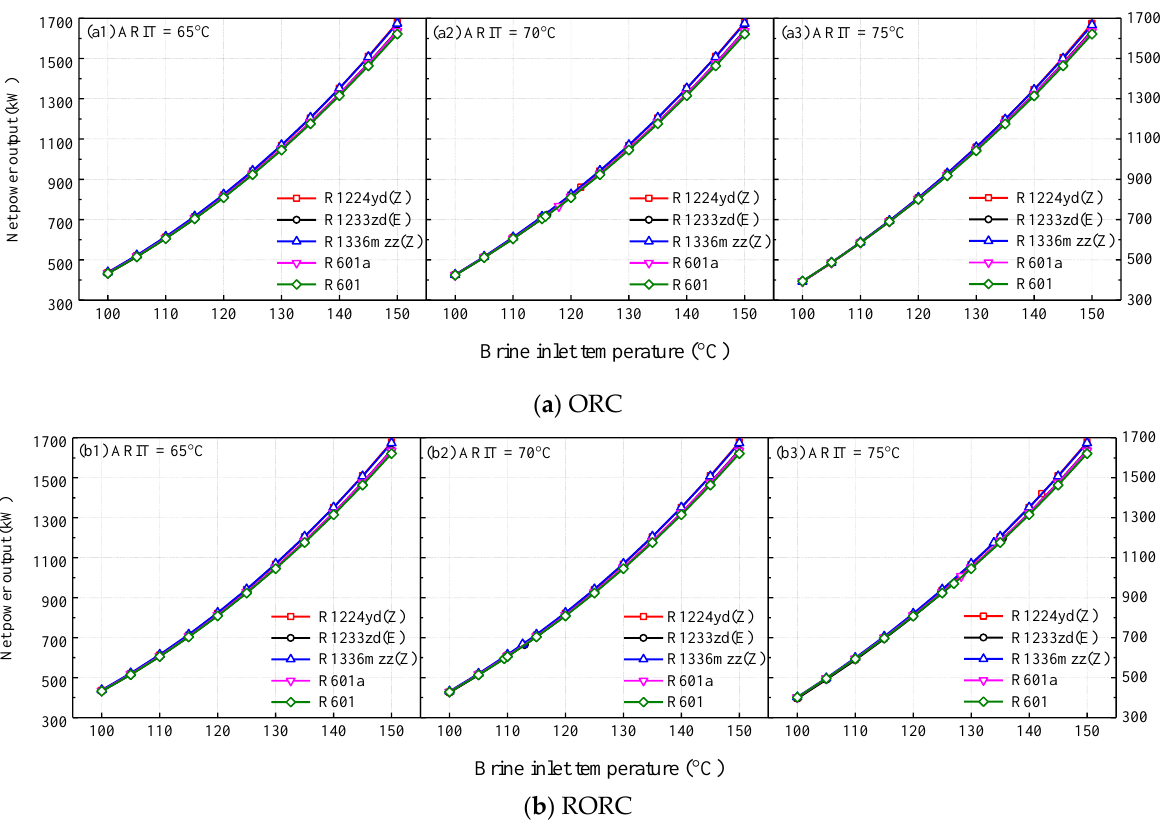
Figure 6. Net power outputs for ( a ) ORCs and ( b ) RORCs at the optimal conditions for various BITs and ARITs.